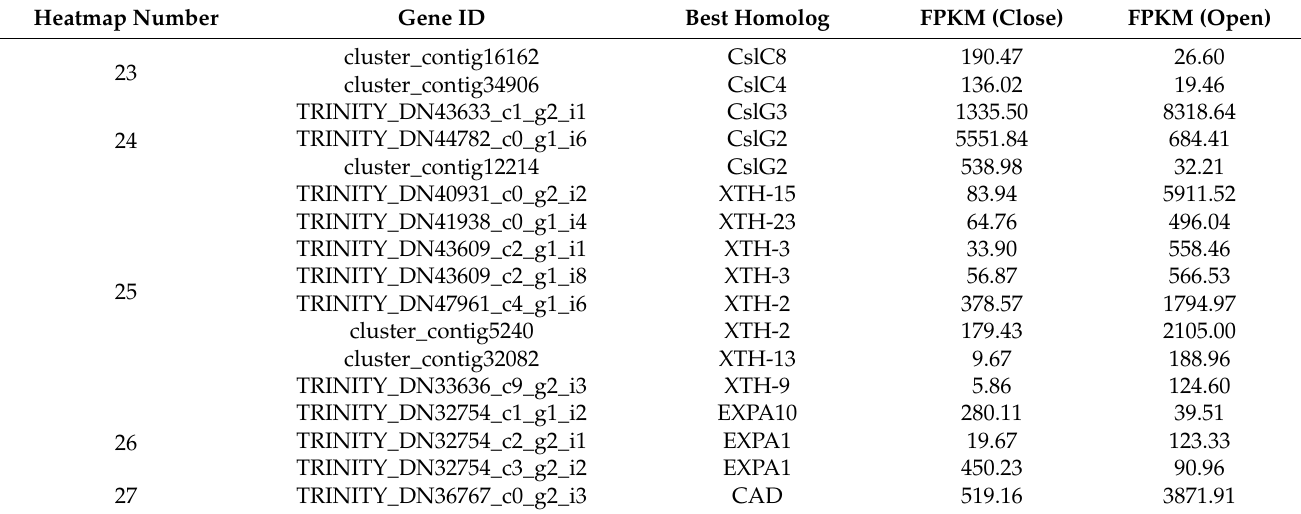
Table 3. Expression levels of genes related to cell wall modification.